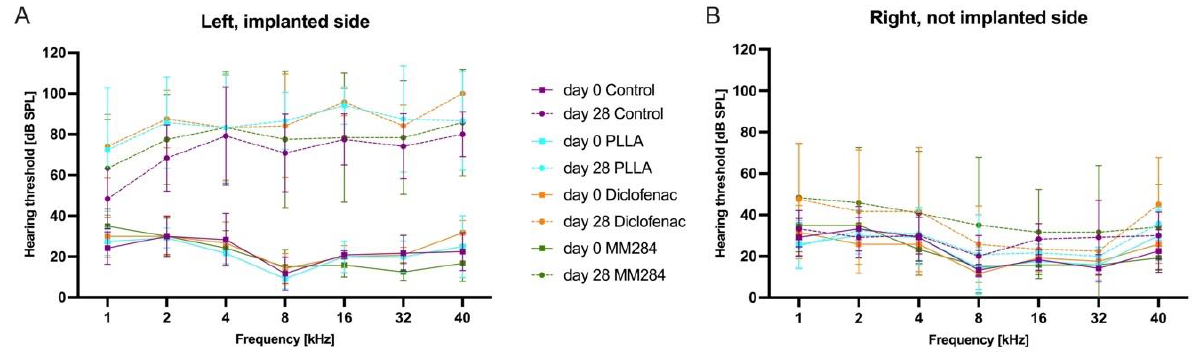
Figure 3. Hearing threshold determination using AABR measurement of the ( A ) left, implanted and ( B ) the right, not-implanted side on day 0 before implantation (solid lines) and after 28 days of implantation (dashed lines). Mean ± SD.